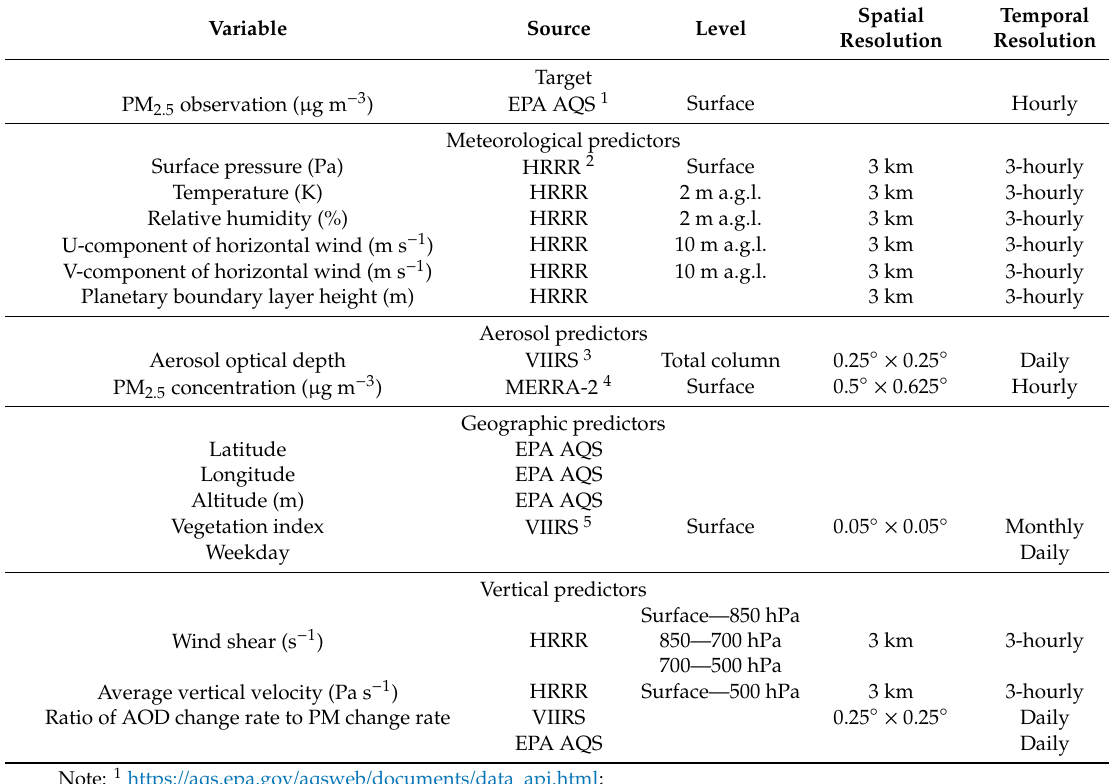
Table 1. List of variables used in this